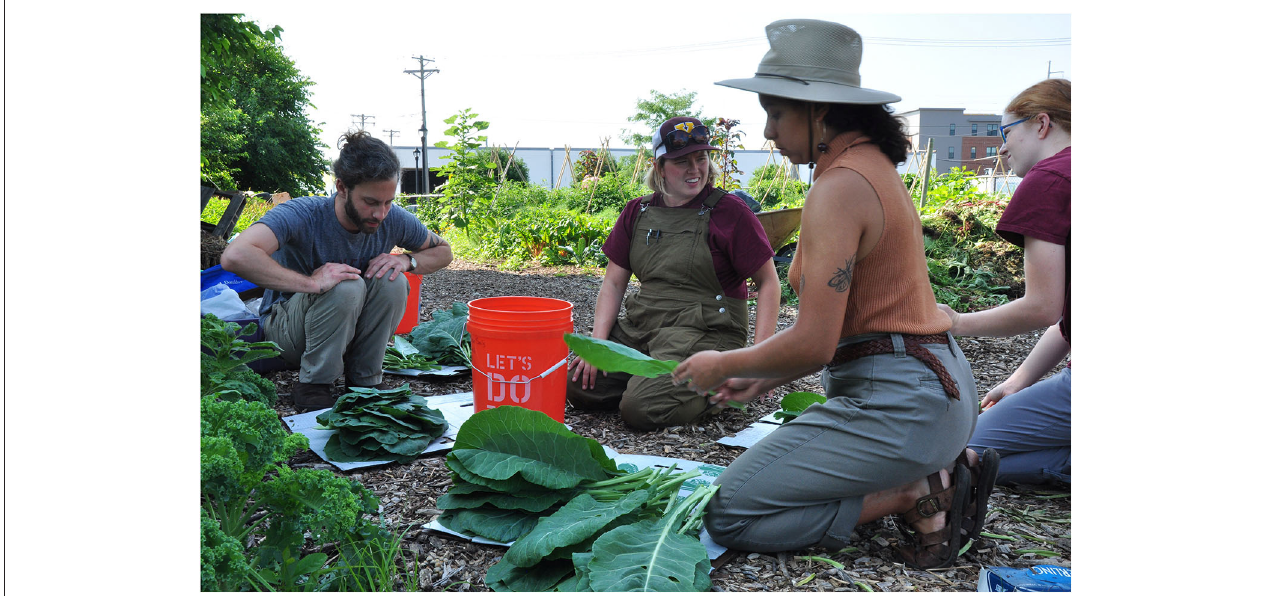
FIGURE 3 | Co-developing research methods—Origins of “The Collard Crew.” Photo credit: Stacy Nordstrom. Pictured (from left to right): Tanner, Kat, Dania, and Madison. Researchers and partners often referenced that an important example of the participatory research process was how we chose the crop for the current ecosystem services project. The pilot study had grown kale—but no one was very excited about having that much kale for 3 years. Over the winter prior to the first field season for this project, Jennifer had one-on-one conversations with each grower about what crops worked best for their goals and, during the yearly “All-Hands” Meeting with all partners and researchers, we used consensus decision making to ultimately choose collard greens. This choice not only better reflects neighborhood and community preferences but also represents a significant research gap; despite the importance of collard greens to Black communities, especially diaspora communities formed during the Great Migration, there is limited representation of this crop in scientific research. Finally, growers expressed appreciation that researchers asked for their expertise in how to harvest, wash, and package the greens to meet their specific sale/distribution